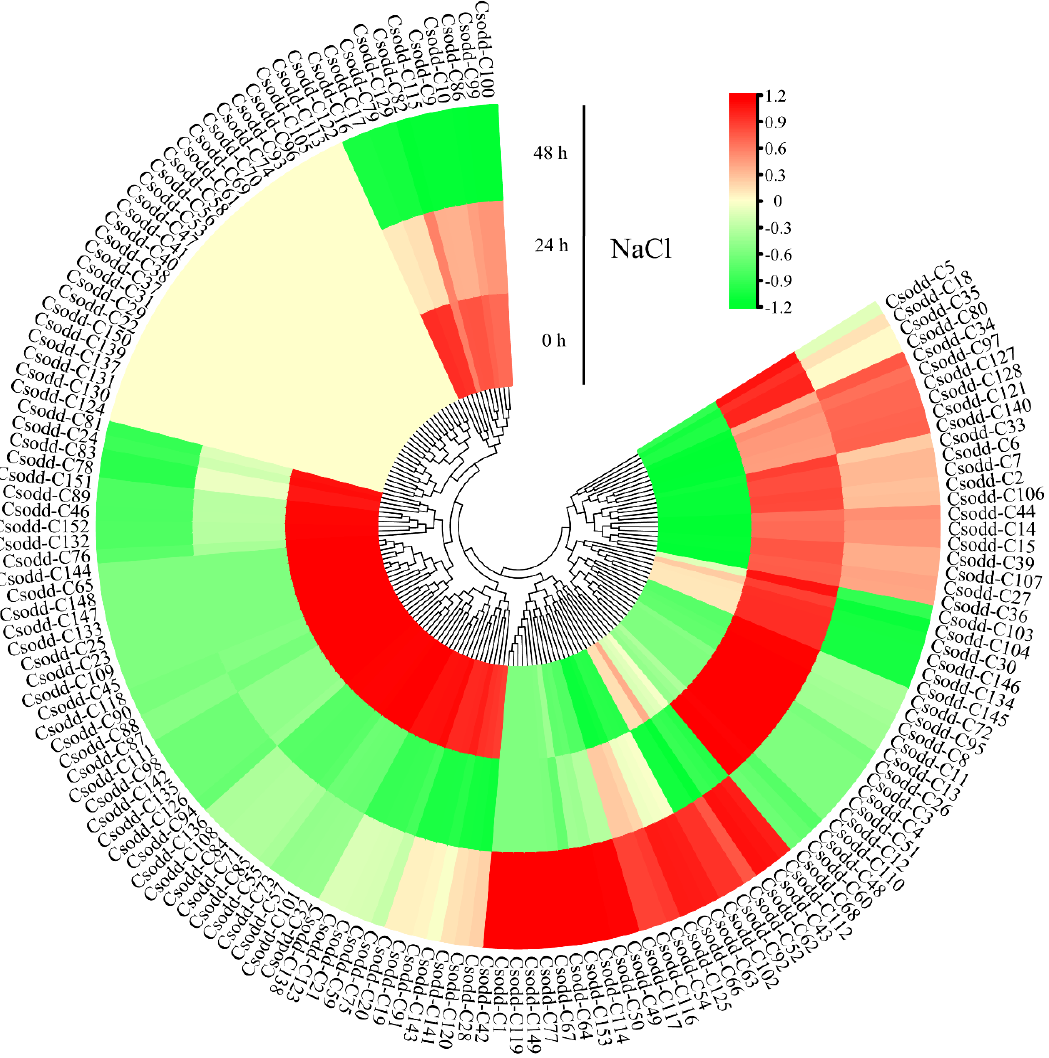
Figure 8. Gene-expression pattern of Cs2ODD − C genes in C. sinensis after NaCl treatment by RNA − seq. The scale bars represent the log2 transformations of the FPKM values. The colors from red to green indicate the highest-to-lowest log2 (FPKM) values of each gene under the NaCl